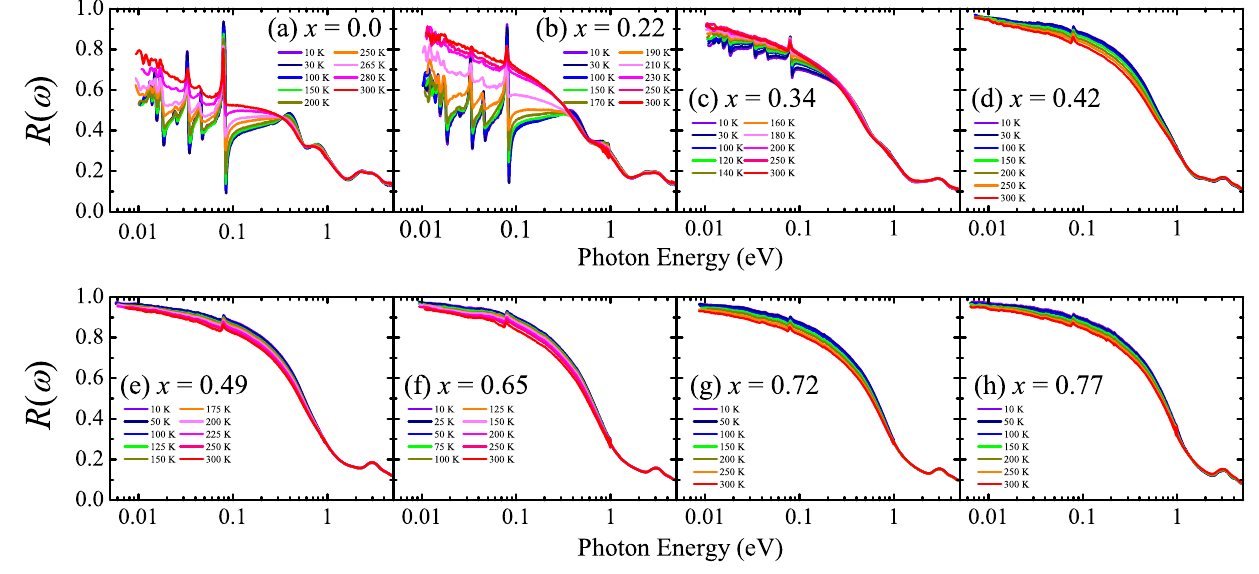
Figure 1. Temperature-dependent reflectivity spectra R ( ω ) of Sr 3 (Ir 1- x Ru x ) 2 O 7 with ( a ) x = 0.0, ( b ) x = 0.22, ( c ) x = 0.34, ( d ) x = 0.42, ( e ) x = 0.49, ( f ) x = 0.65, ( g ) x = 0.72, and ( h ) x = 0.77 at selected